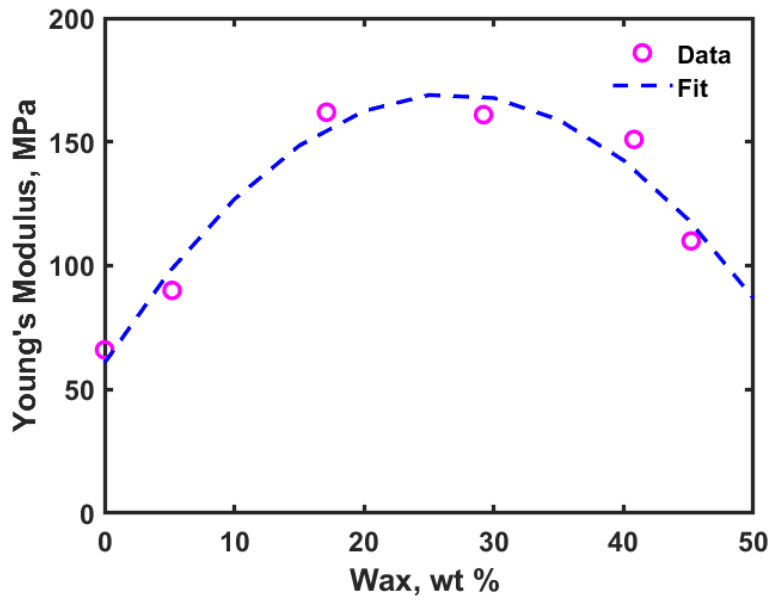
Figure 5. Young’s modulus versus weight percent of PE-wax blends.